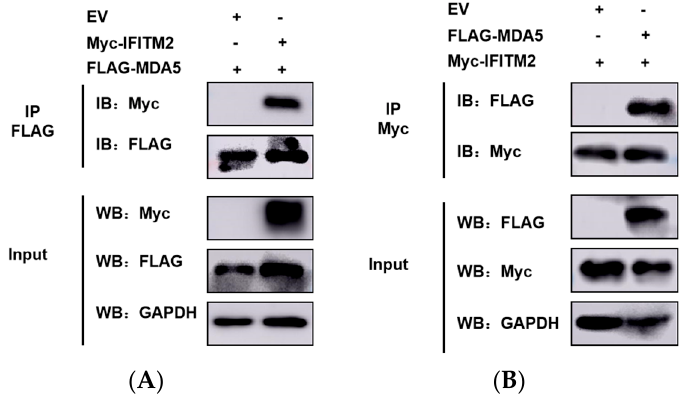
Figure 7. HEK293 cells were transfected with pCMV − Myc − IFITM2 (1 µg) or pCMV − Myc empty vector (EV, 1 µg) together with FLAG − MDA5 (0.5 µg) for 30 h before performing co − immunoprecipitations and immunoblo tt ing with either anti − FLAG ( A ) or anti − Myc ( B ) antibodies. Anti − FLAG or anti − Myc antibody was used to incubate protein G agarose. The precipitates were mixed with SDS bu ff er and boiled for 5 min at 95 °C. After centrifugation at 6000 rpm for 1 min, the supernatant was collected and used for FLAG − tagged MDA5 and Myc − tagged IFITM2 analysis.